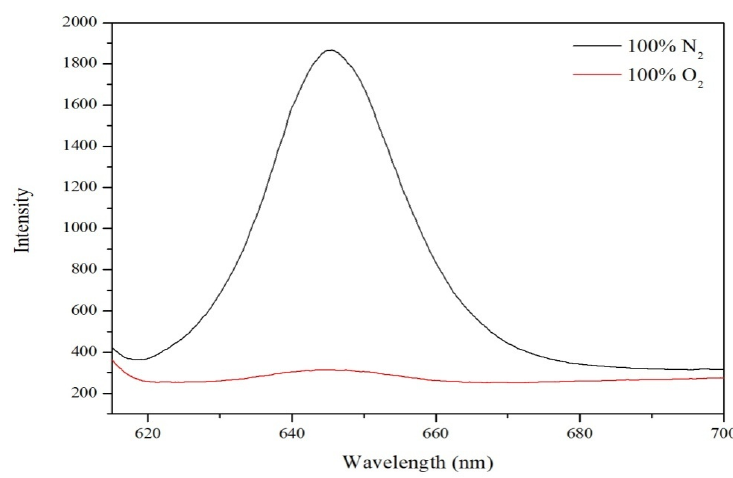
Figure 2. The emission spectra of PtTFPP in N 2 and air environment.